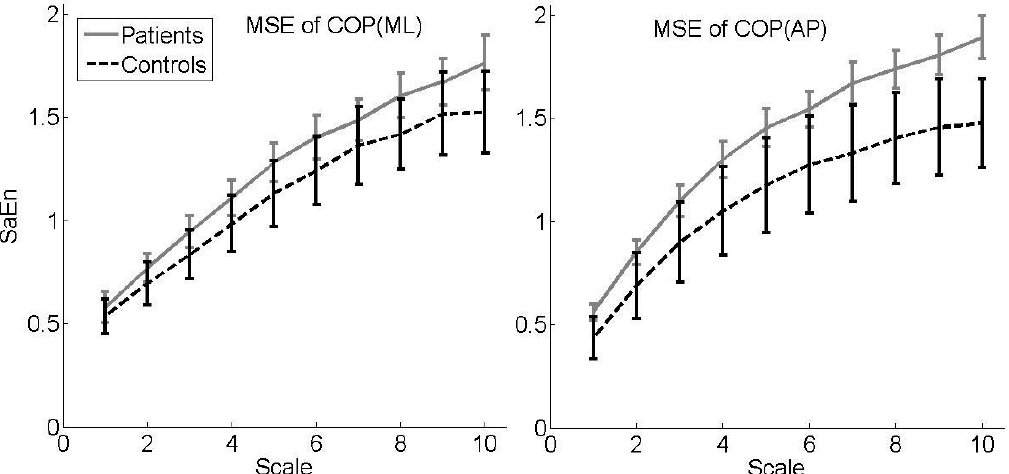
Figure 1. Sample means with 95% confidence intervals of sample entropy (SaEn) by scale i = 1, …, 10 for COP (ML) ( left panel) and COP (AP) ( right panel) for controls vs. patients. Scale i corresponds to a time scale in seconds (s) of 3i s (e.g., i = 1 ˆ = 0.15 s). MSE = multiscale entropy, COP = center of pressure, ML = medial–lateral, AP = anterior–posterior.